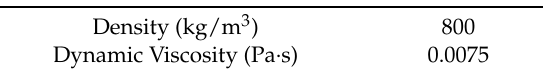
Table 2. Fluid properties at 80 °C .